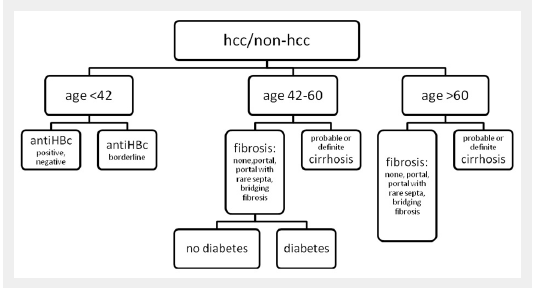
Hierarchial tree of important risk factors. Data for each level (left out of graph to conserve comprehensibility): level 1 (hcc/non-hcc): nonhcc = 96.2% (3,260), hcc = 3.8% (130); level 2 (age<42): non- hcc = 98.9% (1,639), hcc = 1.1% (19); level 2 (age 42–60): n on-hcc = 95.5% (1,337), hcc = 4.5% (63); level 2 (age>60): non-hcc = 85.5% (284), hcc = 14.5% (48); level 3 (anti-HBcpos/neg): non-hcc = 99.1% (1,570), hcc = 0.9% (14); level 3 (anti-HBc borderline): non-hcc = 93.2% (69), hcc = 6.8% (5); level 3(fibrosis: none.): non- hcc = 96.9% (1,099), hcc = 3.1% (35), level 3 (cirrhosis): non-hcc = 89.5% (238), hcc = 10.5% (28), level3 (fibrosis: none) non-hcc = 92% (231), hcc = 8% (20); level 3(cirrhosis): non-hcc = 65.4% (53), hcc = 34.6% (28); level 4 (no diabetes) : non-hcc = 97.3% (1,016), hcc = 2.7% (28), level 4 (diabetes): non-hcc = 92.2% (83), hcc = 7.8%